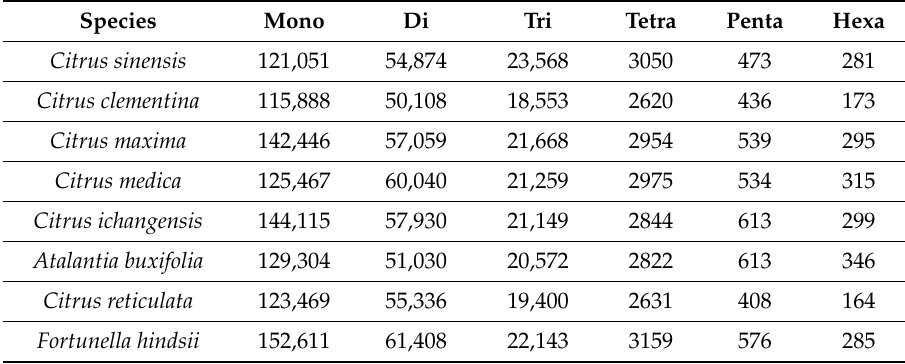
Table 3. Distribution of predicted SSR motif types in each of the Citrus